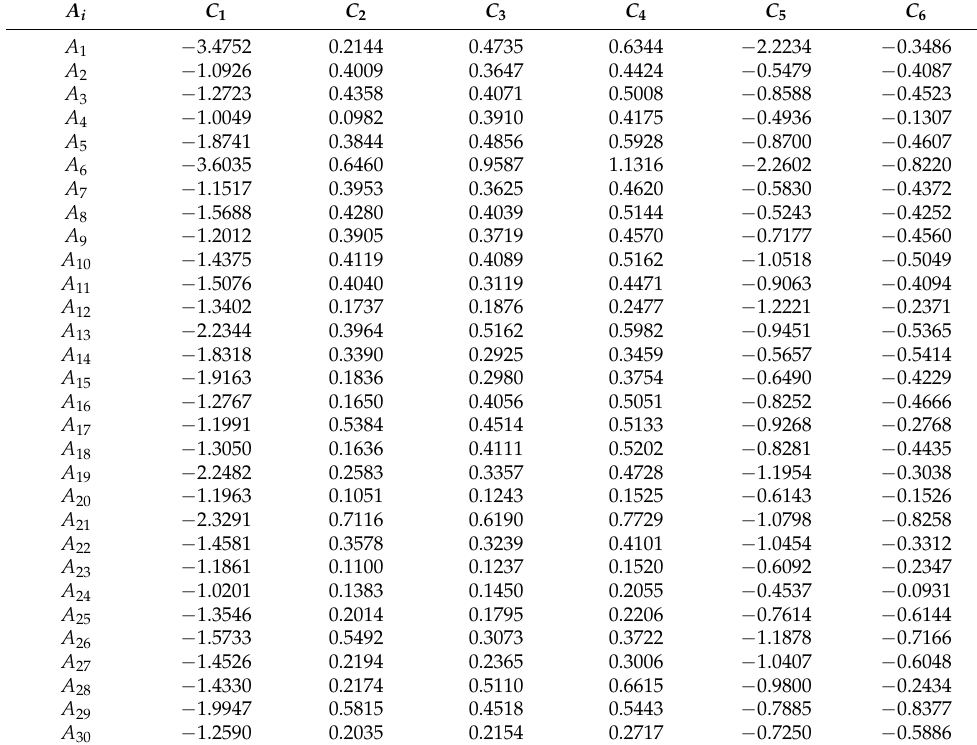
Table 5. Sensitivity analysis for COMET.